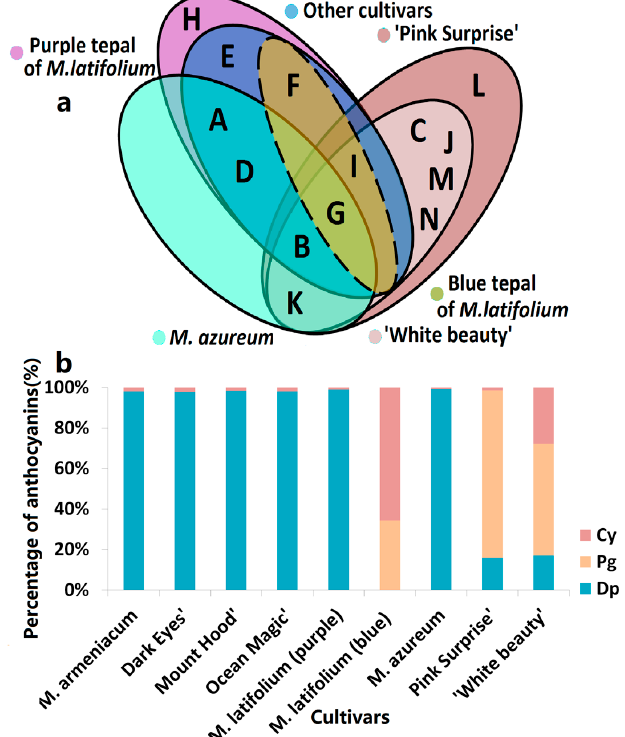
Figure 2. Anthocyanins distribution in tepals of eight grape hyacinth cultivars. ( a ) Venn diagram of anthocyanins distribution in different grape hyacinth cultivars. A–K: Refer to Table 1; ( b ) Percentage of Dp, Cy, Pg-type anthocyanins in tepals of different grape hyacinth cultivars. Flower color was recorded as three-dimensional CIEL*a*b* values and reproduced by photoshop using L, a*, b* values at stage 4. Cy—cyanidin; Dp—delphinidin; Pg—pelargonidin.